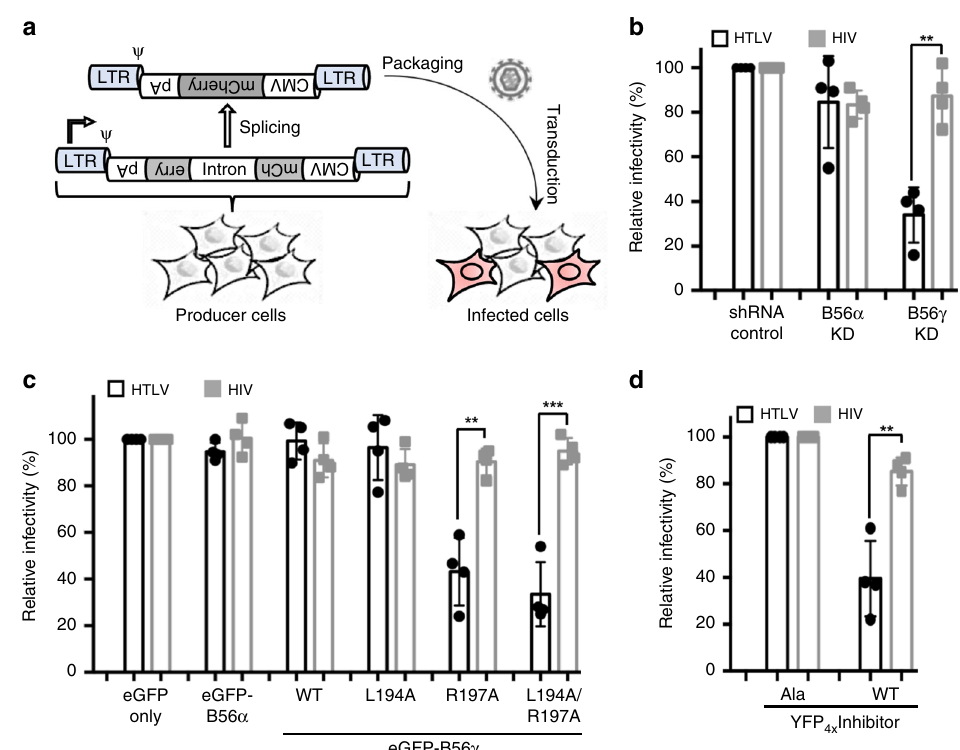
Fig. 3 B56 γ plays an important role in HTLV-1 infection. a A schematic diagram of the HTLV-1 and HIV-1 infection assay system. Fluorescence signal can only be generated following removal of the intron disrupting mCherry (producer cells) and subsequent reverse-transcription and integration of the viral genome (infected cells). b Relative infectivity of the indicated retroviral vectors in B56 α or B56 γ knockdown cells compared to controls. c Relative infectivity of the indicated retroviral vectors in cells overexpressing the indicated B56 construct compared to eGFP alone. d Relative infectivity of the indicated retroviral vectors in cells overexpressing four copies of a repeat peptide sequence containing L PT I H E (WT) compared to cells expressing four copies of the peptide sequence A PT A H A (Ala). ** P < 0.01; *** P < 0.001 by the unpaired Student t test. Data shown are from four independent replicates.